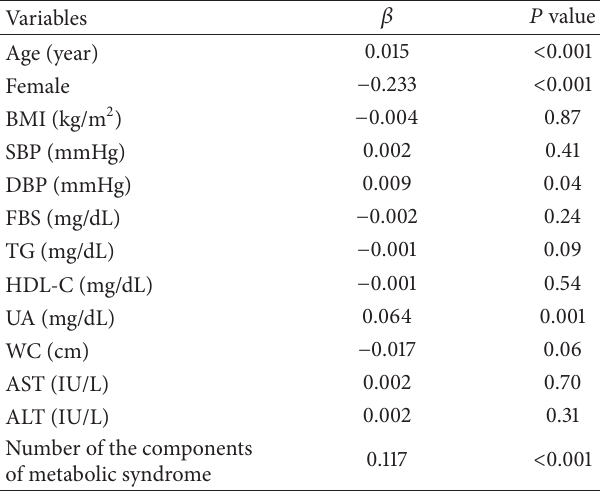
Table 2: Multiple linear regression between CAVI and laboratory